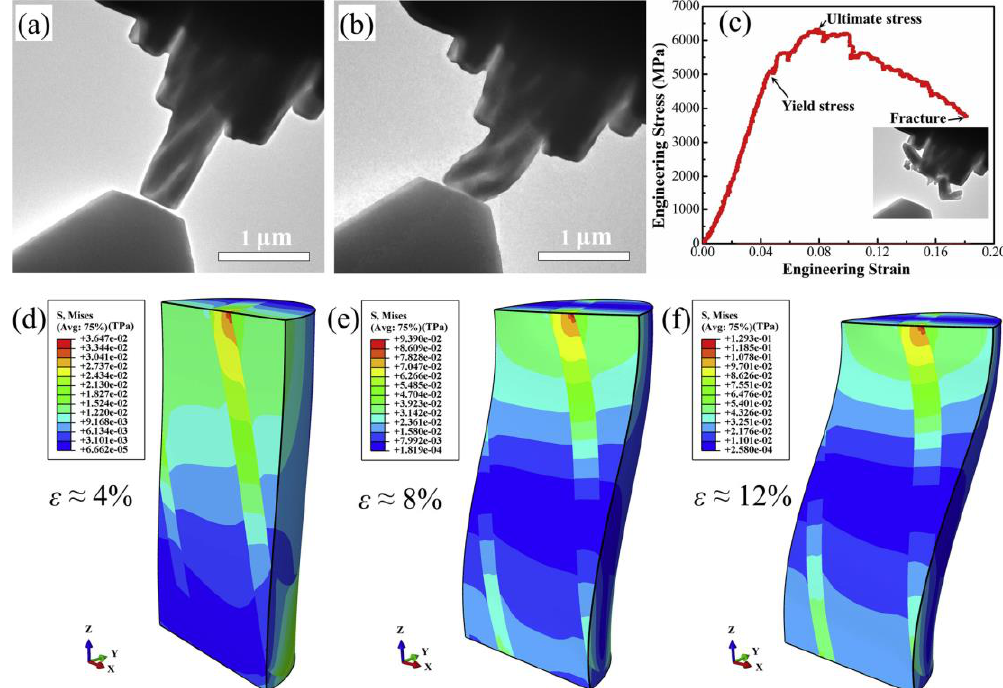
Figure 14. Micropillar compression test of rod-like Al 2 O 3 -GdAlO 3 nanoeutectic with rods oriented toward the compression axis: ( a ) bright-field TEM image before deformation, ( b ) bright-field TEM image after deformation, ( c ) the corresponding engineering stress-strain curves and ( d – f ) FEM simulation of the stress-field distribution at different engineering strains. Reproduced with permission from Reference [113], Copyright © 2020 Elsevier Ltd.